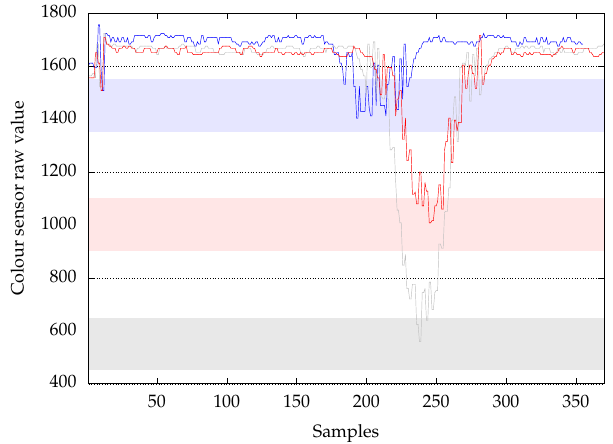
Figure 2. Time series of the three colours &